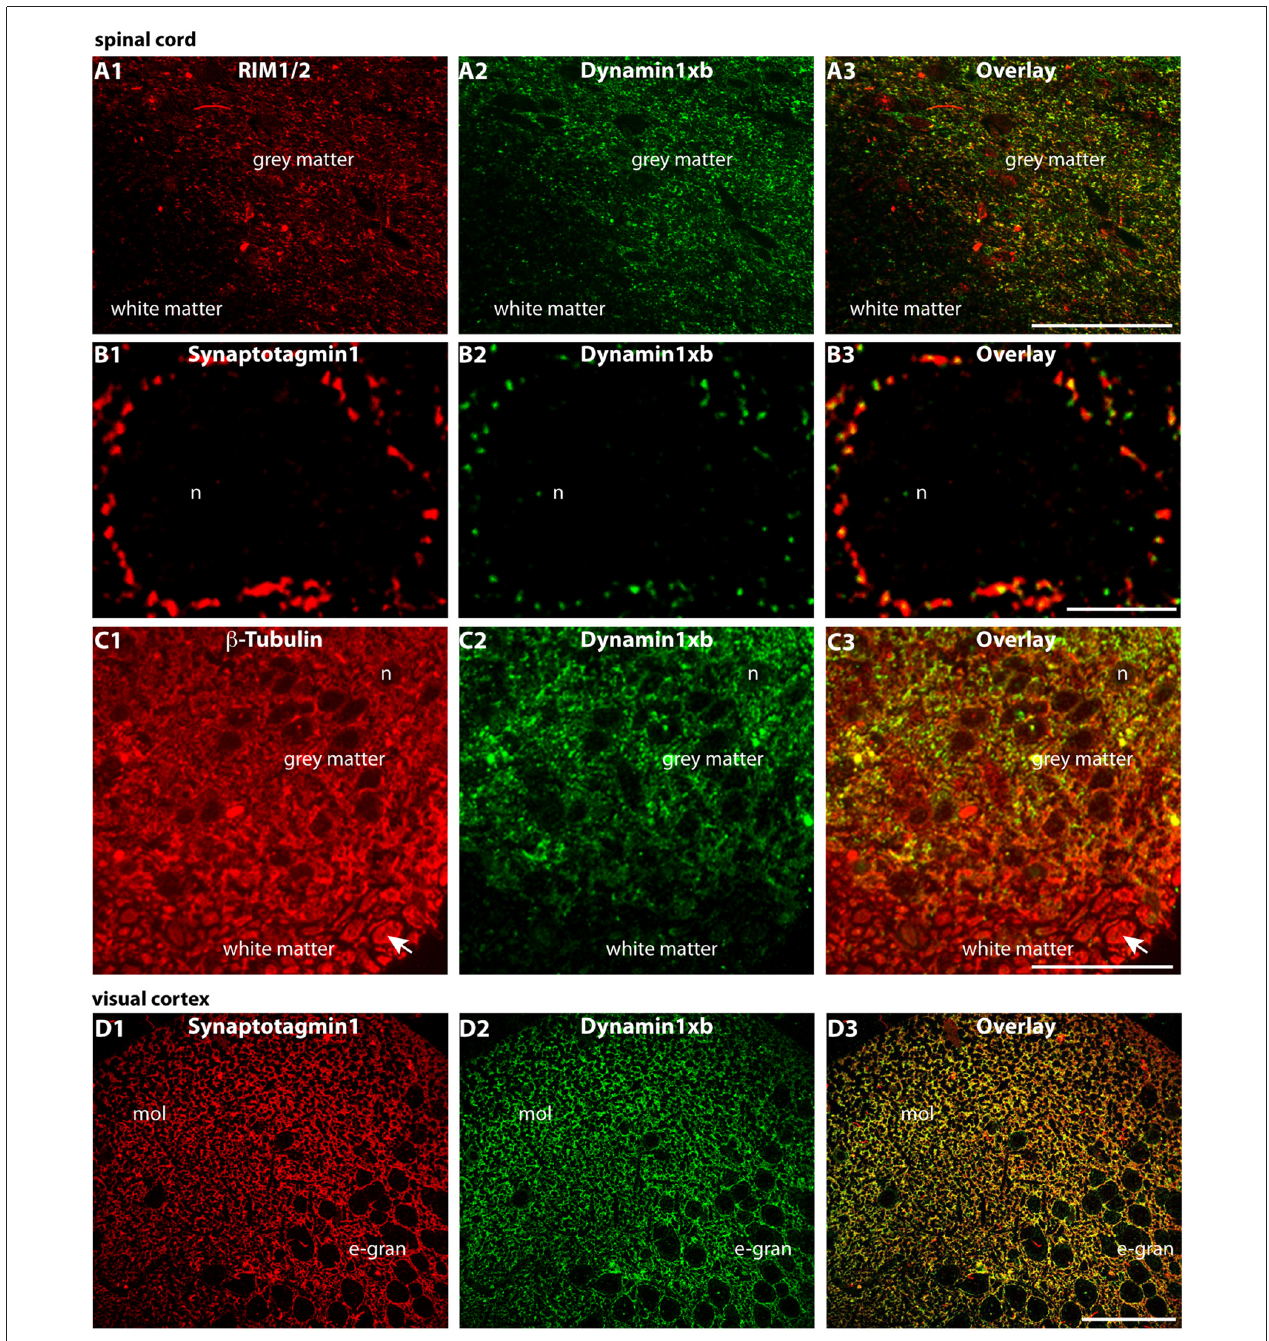
FIGURE 7 | Semi-thin (0.5 µ m-thin) sections of the mouse spinal cord (A–C) and the mouse visual cortex (D) double-immunolabeled with the monoclonal antibody against dynamin1xb and the indicated other primary antibodies. The rabbit polyclonal antibodies against synaptotagmin1 (B,D) and RIM1/2 (A) were applied to label the synapses in the spinal cord. Immunolabeling with rabbit polyclonal antibodies against β -tubulin was used to also visualize the neuronal axons in the white matter of the spinal cord (C) . We observed a strong dynamin1xb immunosignal in the gray matter of the spinal cord whereas the white matter that contains many axons (but virtually no synapses) was largely unlabeled by the dynamin1xb antibody. High-resolution confocal analyses revealed the presence of dynamin1xb in synatotagmin1- labeled presynaptic terminals that contact the cell bodies of motor neurons in the gray matter of the spinal cord (B) . Similarly, also in the visual cortex (D) , we observed a dynamin1xb immunolabeling signal that largely overlapped with synapses as judged by anti-synaptotagmin1 immunolabeling. Arrow in (C) points to an exemplary axon in the white matter of the spinal cord that was immunolabeled with anti- β -tubulin antibodies. (A,C) were obtained by epifluorescence microscopy; (B,D) by confocal microscopy. Abbreviations: n, nucleus of a motor neuron in the anterior horn of the spinal cord; mol, molecular layer; e-gran, external granule cell layer. Scale bars: 50 µ m (A,C) ; 10 µ m (B) ; 30 µ m (D) .